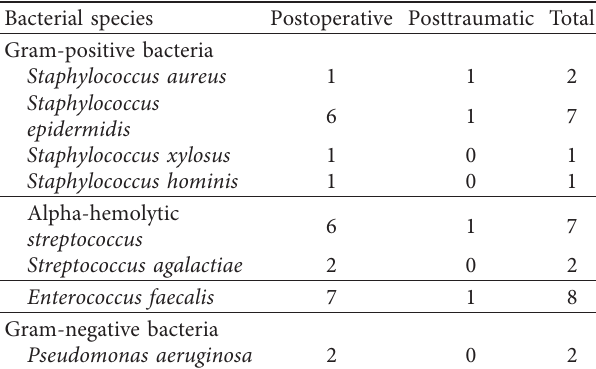
Table 3: Microbiological